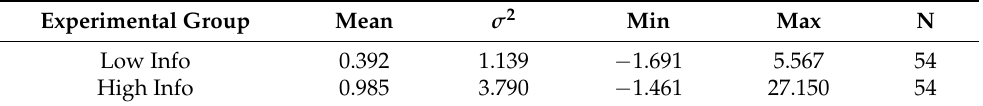
Table 2. Asks’ sensitivity to extreme values: The δ parameter across experimental groups. Experimental